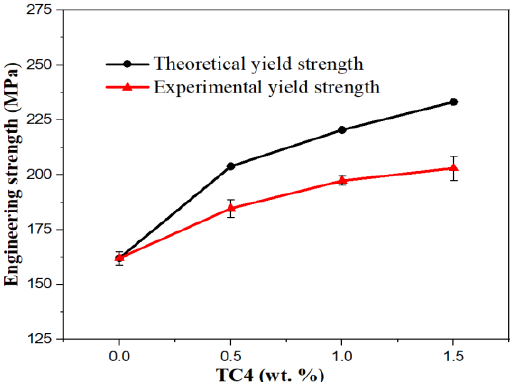
Figure 12. Comparison of theoretical and experimental YS of composites.